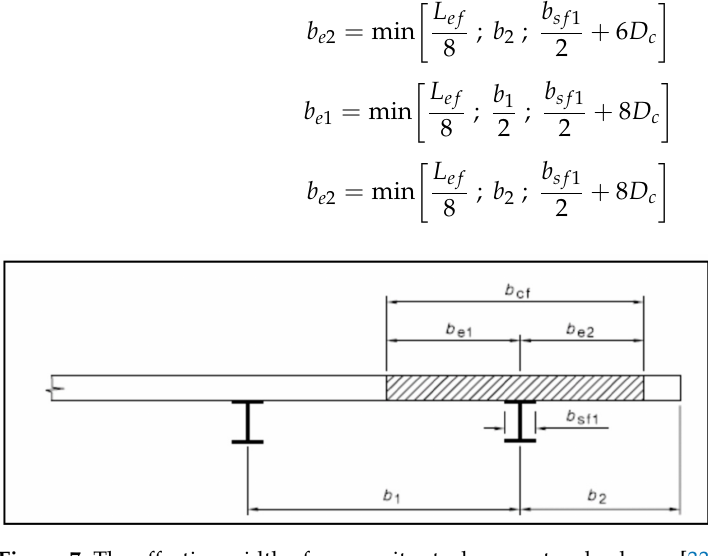
Figure 7. The effective width of composite steel–concrete edge beam [33].